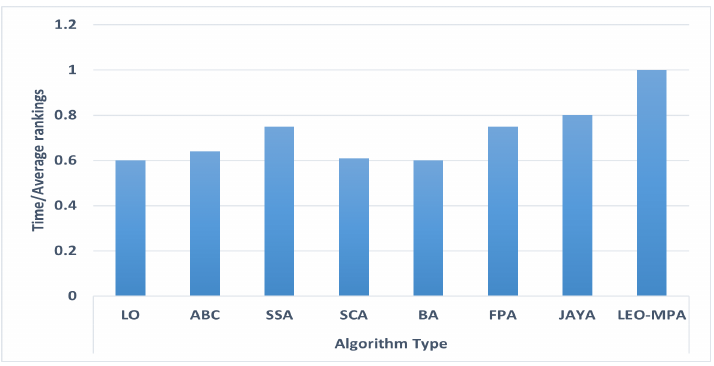
Figure 11. Time average rankings of all comparative methods on all test